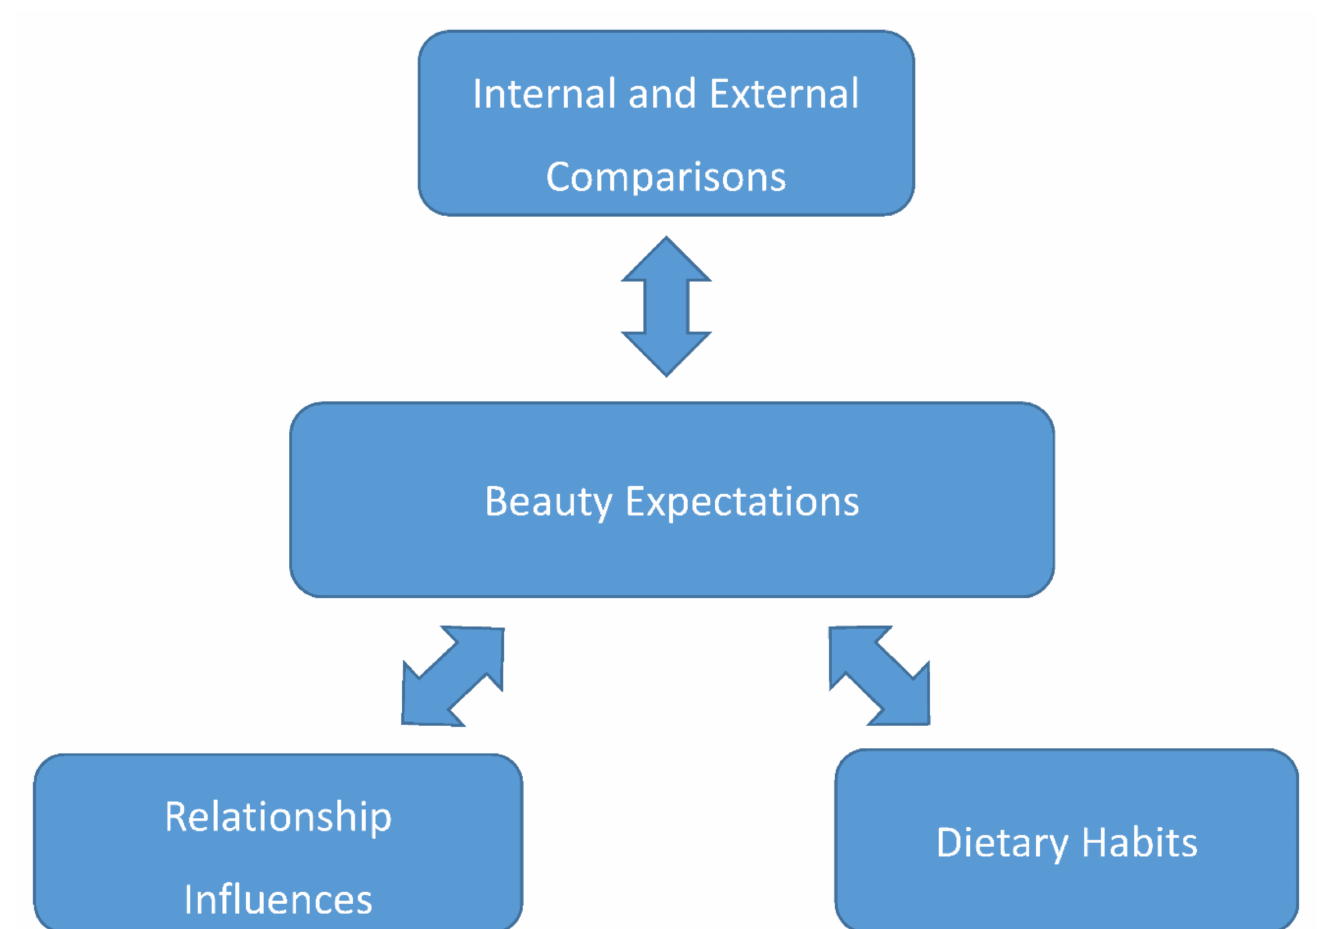
Figure 1. Relationship between beauty expectations and